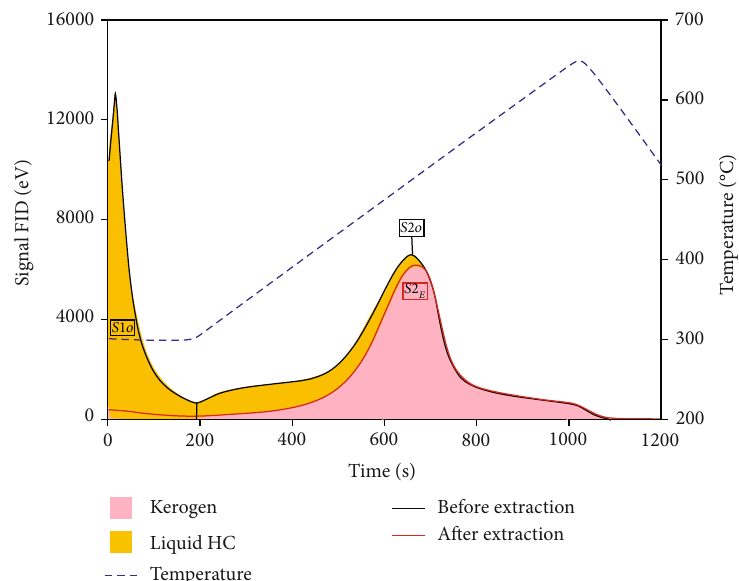
Figure 6: Results of Rock Eval pyrolysis experiments showing characteristics of S 1 and S 2 peaks of shale rock sample before (black line) and after (red line) extraction with organic